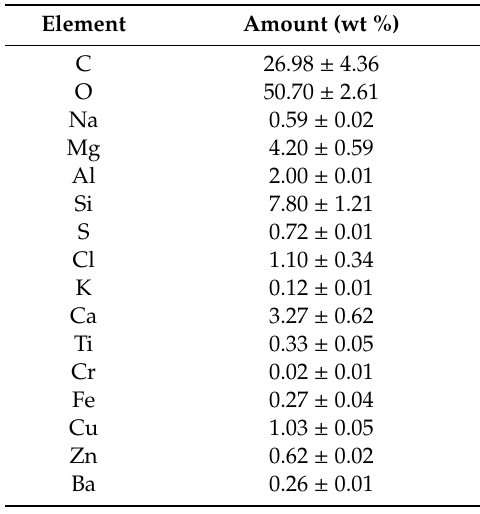
Table 2. Results of EDX analysis on the ELV residual after thermal treatment at 800 ◦ C in air and homogenization of the recovered